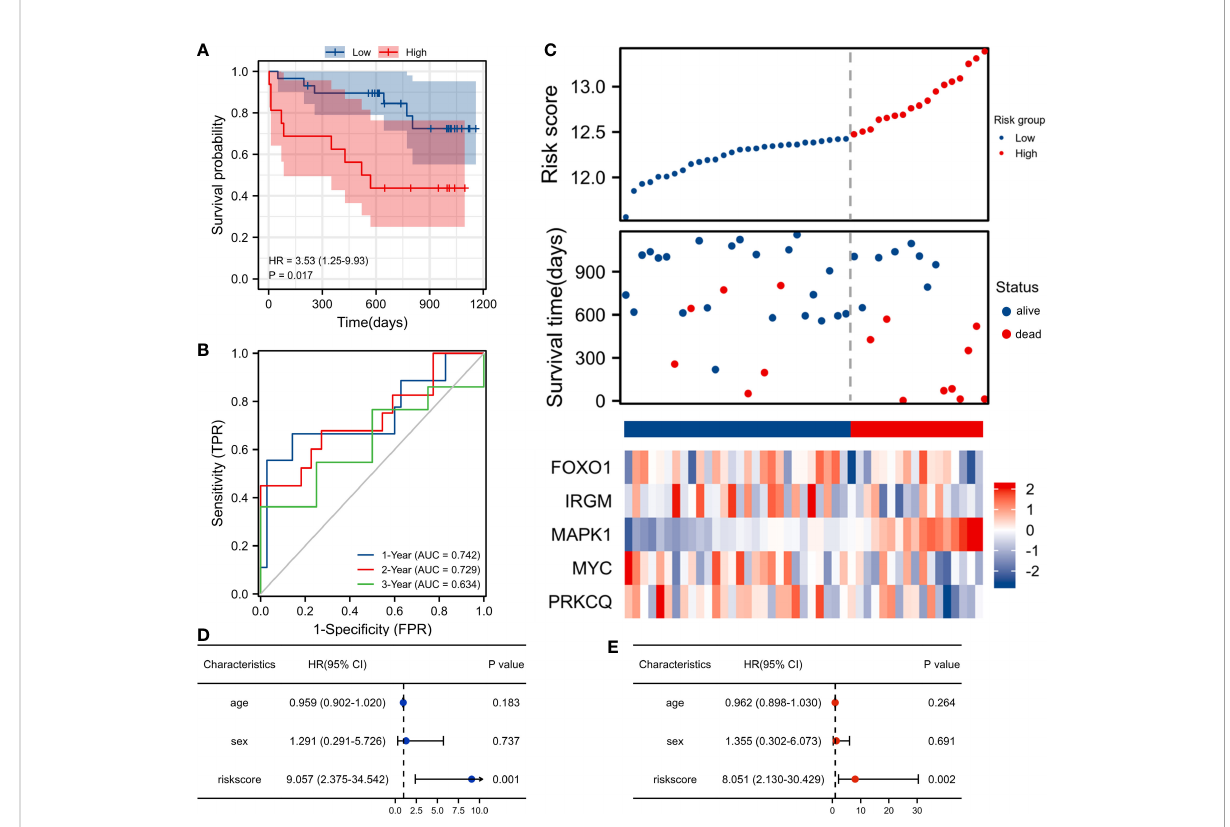
FIGURE 4 Validation of the autophagy-associated prognostic model in GSE27957. (A) Survival curve of high-risk score and low-risk score groups. (B) ROC curves evaluated the ef fi ciency for predicting 1-, 2-, and 3-year survival. (C) Risk plot distribution, survival status, and heatmap of fi ve genes expression. (D) Univariate cox analysis of riskscore in GSE27957. (E) Multivariate cox analysis of riskscore in